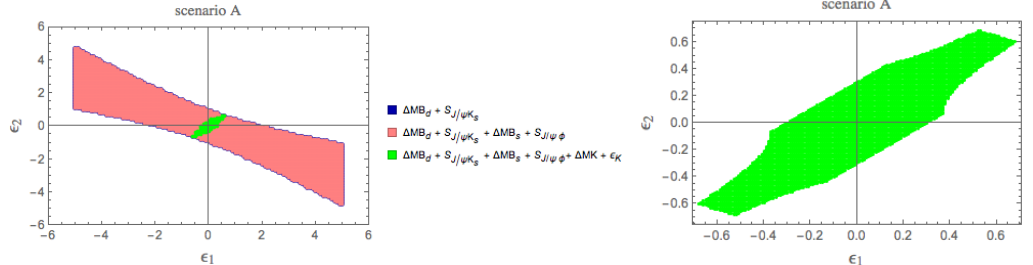
Figure 1 . Scenario A. Left panel: allowed region in the ( (cid:15) 1 ; (cid:15) 2 ) plane, after imposing (cid:1) F = 2 constraints, as indicated in the legend. Right panel: zoom of the green zone in the left